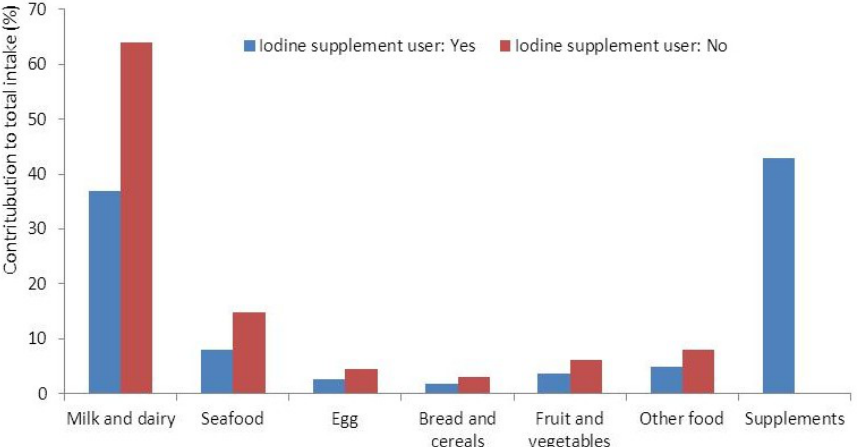
Figure 1. The contribution (%) to maternal iodine intake from food groups and iodine containing supplements in iodine supplement ( n = 19,575) and non-supplement users ( n = 42,329).